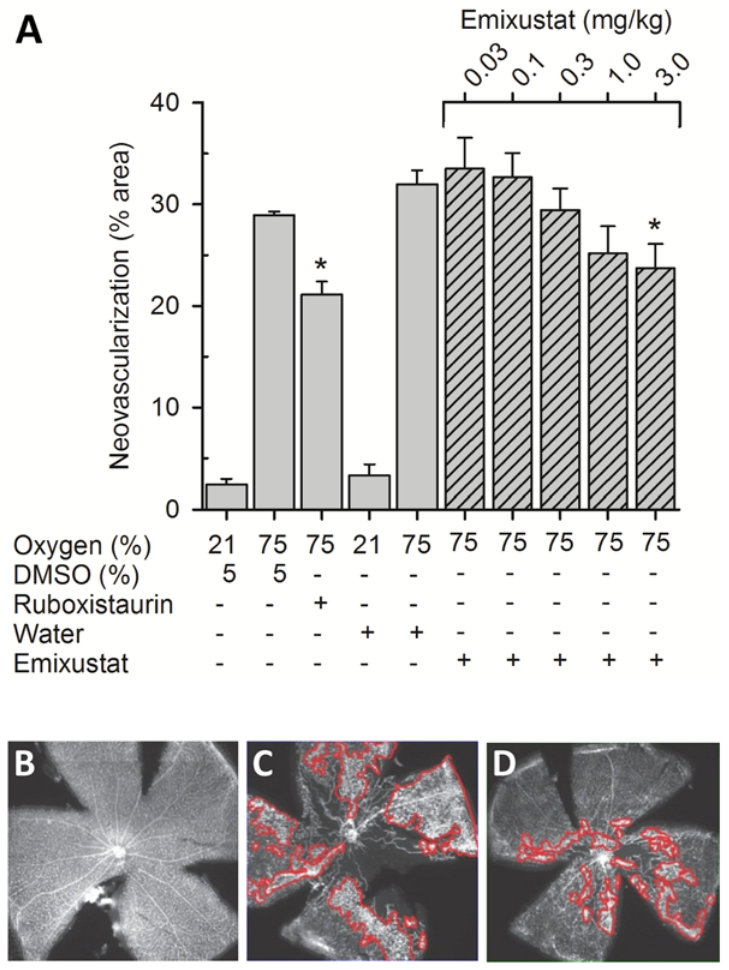
Fig 6. Reduced Retinal Neovascularization. The effect of emixustat on retinal neovascularization was studied in the mouse OIR model. Seven day-old mouse pups were subjected to hyperoxia (75% oxygen) for 5 days. On P12, the mice were returned to room air and daily treatments with ruboxistaurin (10 mg/kg), emixustat (0.03 – 3.0 mg/kg), or appropriate vehicles were administered as described in Methods . Retinal flat mounts were prepared and areas of NV were quantified; these data were compared to data from control mice that were maintained in a normoxic environment (21% oxygen). Mice that were moved from a hyperoxic to normoxic environment, without treatment, showed a significant extent of retinal NV (~30% of the retinal area). Treatment with the ruboxistaurin (positive control) reduced the area of NV to ~20% of the total retinal area. In mice treated with emixustat, a dose-dependent reduction in retinal NV was observed. The reduction in NV at the highest emixustat dose (3.0 mg/kg/day) approached a level that was comparable to that obtained with ruboxistaurin (Fig 6A; * , t-test, p < 0.05). The ED 50 for reduction of retinal NV in emixustat-treated mice was 0.46 mg/kg/day. Representative retinal flat mounts from an untreated, normoxic control, an untreated OIR control, and in a 3 mg/kg emixustat-treated mouse are shown in panels B, C, and D, respectively. Areas of NV, outlined in red tracings, were identified and quantified using Adobe Photoshop